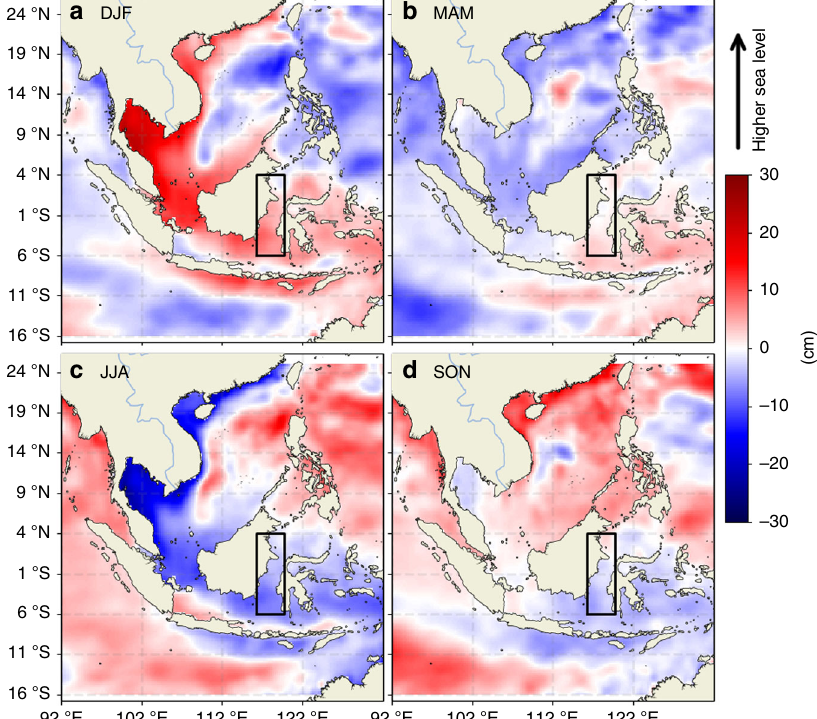
Fig. 9 Composite seasonal maps of sea level anomalies. a – d correspond to the maps for the DJF, MAM, JJA, and SON seasons. The rectangular box (116.25 – 119.75 °E, 6S-4 °N) indicates the region where the meridional pro fi les are shown in Fig.